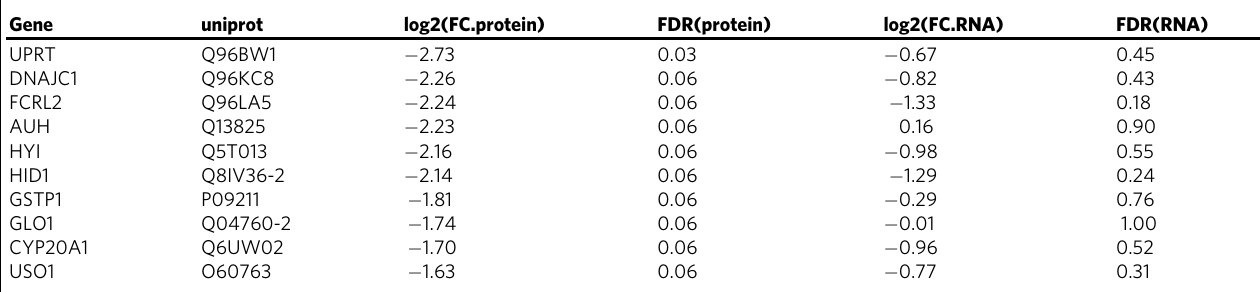
Table 2 Top downregulated proteins detected in global proteomics with their RNAseq pro fi le. Gene